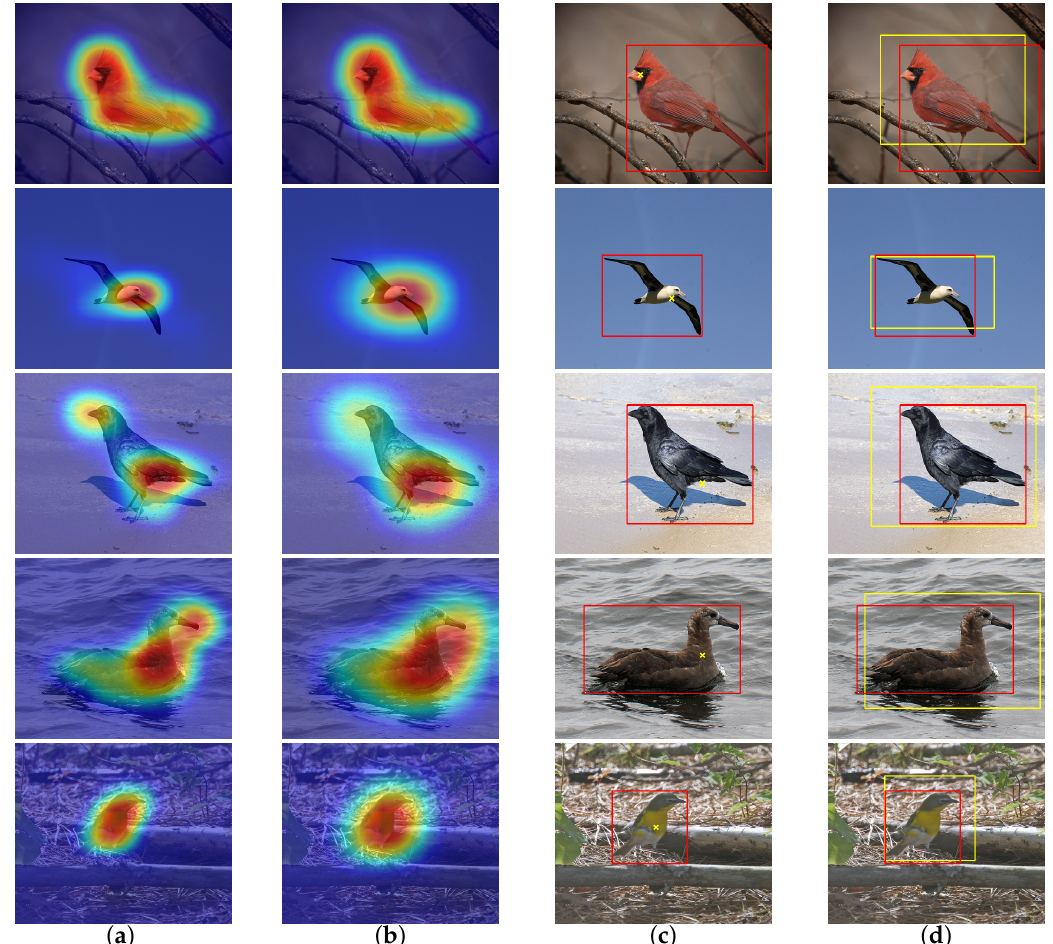
Figure 5. Visualization results in the CUB-200-2011 test set. ( a ) Attention maps (28 × 28), ( b ) attention maps (14 × 14), ( c ) pointing detection results, and ( d ) bounding box detection results. Table 2. Pointing localization error (%) on the CUB-200-2011 test set. Methods Top-1 Err. Top-5 Err.